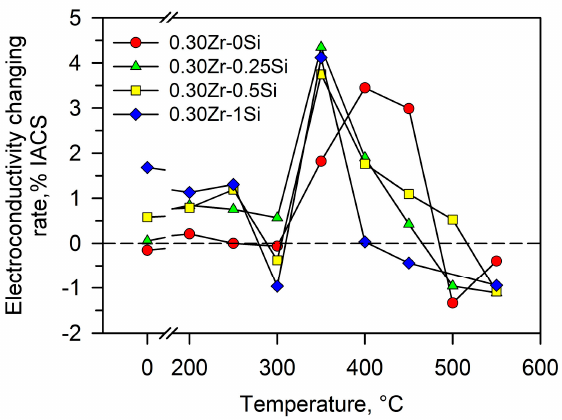
Figure 8. Temperature dependence of the electrical conductivity change of Al-1% Fe-Si-0.3% Zr alloys.